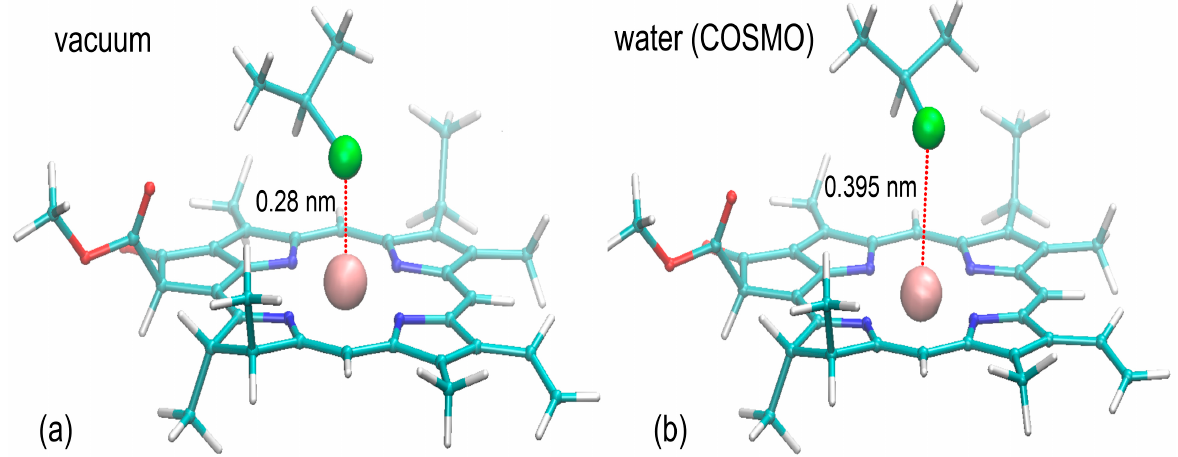
Figure 8. The structures of the CH 3 -CHCl-CH 3 molecule interacting with the core of chlorophyll a . The structures were obtained in the result of ab initio geometry optimization carried out at the DFT/B3LYP/6-311G** level of theory either in the absence ( a ) of presence ( b ) of implicit water solvent. The Mg 2+ cation and the coordinating Cl atom are shown as balls. The interatomic distances discussed above are reflected by the calculated binding energies corresponding to the environment of the given system. For the vacuum systems the determined binding energies are more favorable and equal to 18.8–25.5 kJ/mol, de- pending on the system. In the presence of water, those values are reduced to 9.3–11.9 kJ/mol. Still, even those smaller values correspond to a highly favorable binding and show the existence of attractive interactions between PVC and chlorophyll. The observed differences can be interpreted in terms of the competitive interactions of electronegative ligands for the Mg 2+ ion. In the absence of water, the interactions be- tween Cl and Mg are much more attractive and result in more favorable binding, whereas the binding strength is largely reduced upon introducing the implicit water. The oxygen atoms of water are capable to compete for interactions with Mg 2+ , collectively diminishing the strength of the Cl-Mg 2+ attraction. Thus, it is expected that in the pres- ence of water, PVC-chlorophyll binding is driven not only by the Cl-Mg 2+ coordination, but also by interactions of the CH- π type between the porphyrin rings and aliphatic hy- drogens of PVC. However, due to both large size of involved molecules and extremely high conformational flexibility of the PVC chain, this problem can hardly be accurately addressed by the ab initio calculations. Nevertheless, the presented calculations show